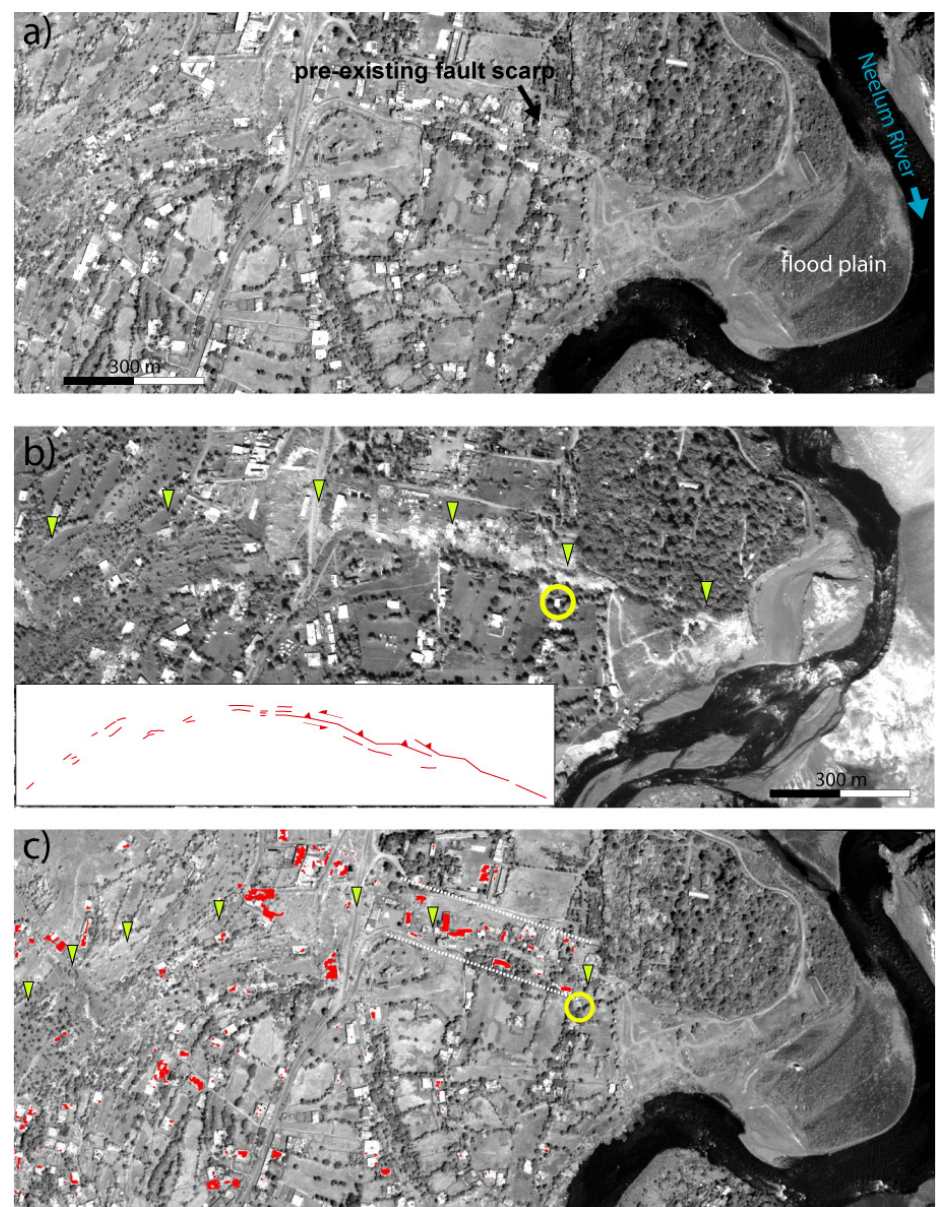
Fig. 4. Detail of the northernmost area of Muzaffarabad. (a) Pre-event image (13 August 2004); (b) post-event image (22 October 2005); green triangles point the main surface rupture. The sketch on left side shows the E-W trending scarp: lateral ramp connecting the left-stepping main thrust fault, 2 . 45 ± 0 . 25m (max vertical separation), ∼ 4 . 6m horizontal shortening and ∼ 0 . 6m left lateral. Refer to (c) for yellow ring symbol; c) damaged houses automatically detected (in red) superimposed on the pre-event image. Intense damaging occurs within the white dashed lines along the fault scarp. Based on our procedure, the building encircled by the yellow ring is undamaged. The same not strongly damaged building, out of the intense damaged zone, and the fault scarp are shown in Fig. 5 of Lin and Guo (2008) being depicted by the Authors through a field